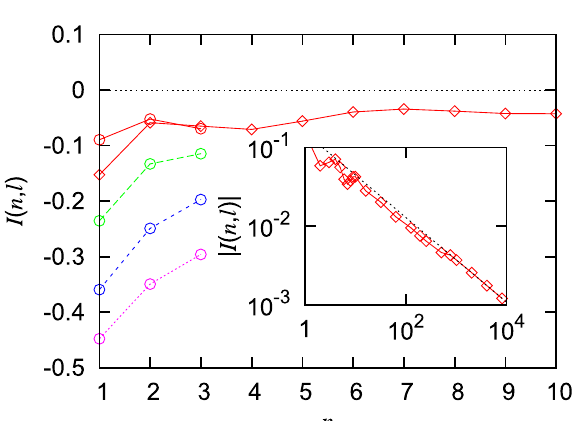
Figure 2. Dependence of I ( n , l ) in Eq. (28) on the cutoff ζ c for w and 4 (blue short dash) for ( a ) n employed the asymptotic expression in Eq. (26) to plot ( c ). The values of angular momentum l are as indicated.